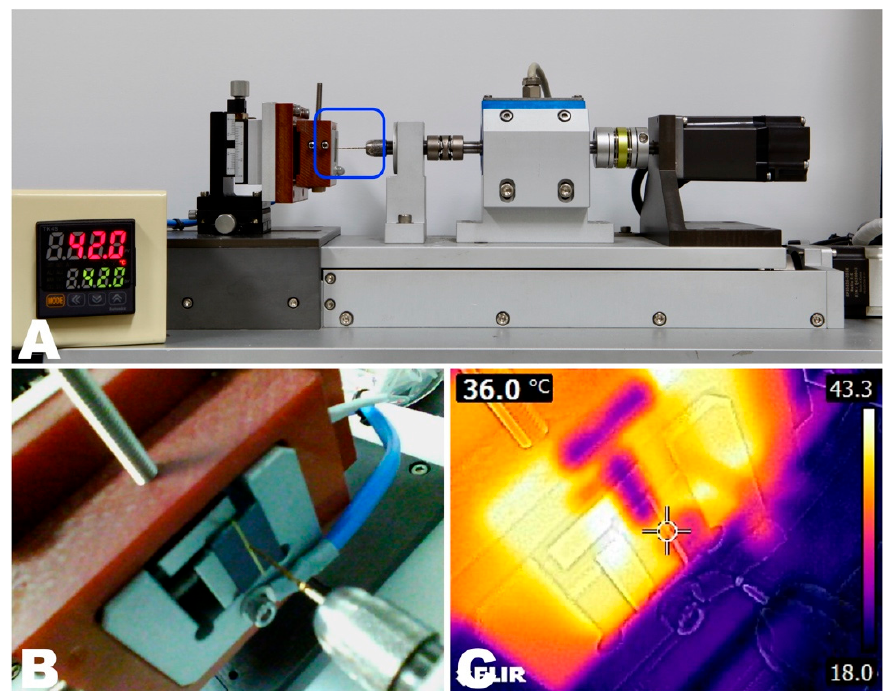
Figure 1. ( A ) Torsional resistance test device (AEndoS) used in this study. Electronic heat controller used to set the test temperatures. ( B ) The Blue box from A shows the instrument’s tip held between brass plates. ( C ) Real-time monitoring of the experimental temperature around the file